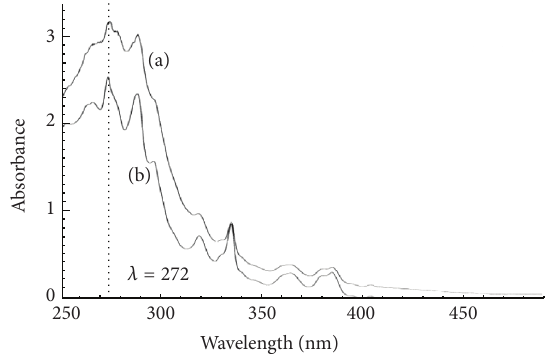
F 2: UV-vis spectra of the PLE extract (a) without silica (no cleanup) and (b) with silica